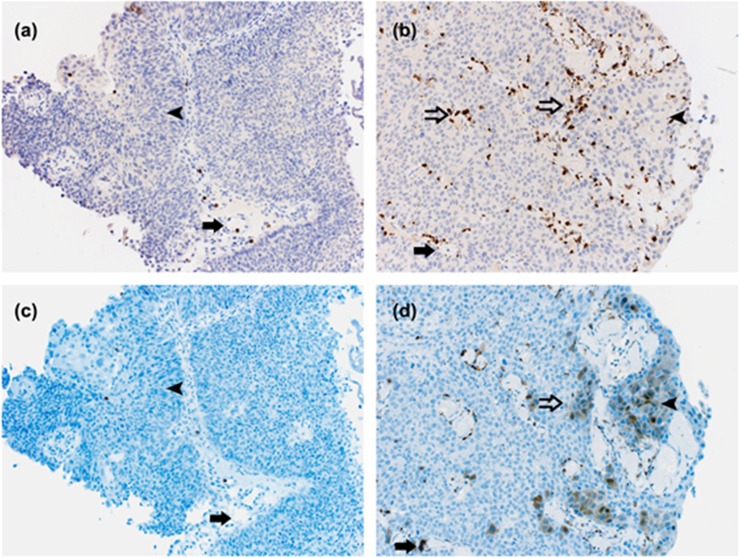
Immunostaining for MPO (a,b) and Calprotectin (c, d) in urothelial carcinoma (TNM [UICC 2017] pTaG3 high-grade without SL [a, c] and pTaG2 high-grade with SL [b, d]). The antibodies are specific for Calprotectin and MPO; solid arrow: intra-capillary neutrophil cell; open arrow: infiltrating neutrophil cell; arrowhead: tumour cell. In high-grade BC without SL less neutrophils are shown in the capillaries (a, solid arrow) which are negative for Calprotectin (c, solid arrow) whereas in high-grade BC with SL capillaries are densely filled (b, solid arrow) and are positive for Calprotectin. In BC without SL neutrophils do not invade the tumour (a, c). In BC with SL neutrophils invade the tumour (b, open arrow) and feature cytoplasmatic staining of Calprotectin (d, open arrow). Tumour cells in high-grade BC without SL are Calprotectin negative (a, c, arrow head), whereas tumour cells in high-grade BC with SL show Calprotectin staining (b, d, arrow head). Not all tumour cells in high-grade BC with SL are Calprotectin positive. MPO, myeloperoxidase, SL, sterile leukocyturia.